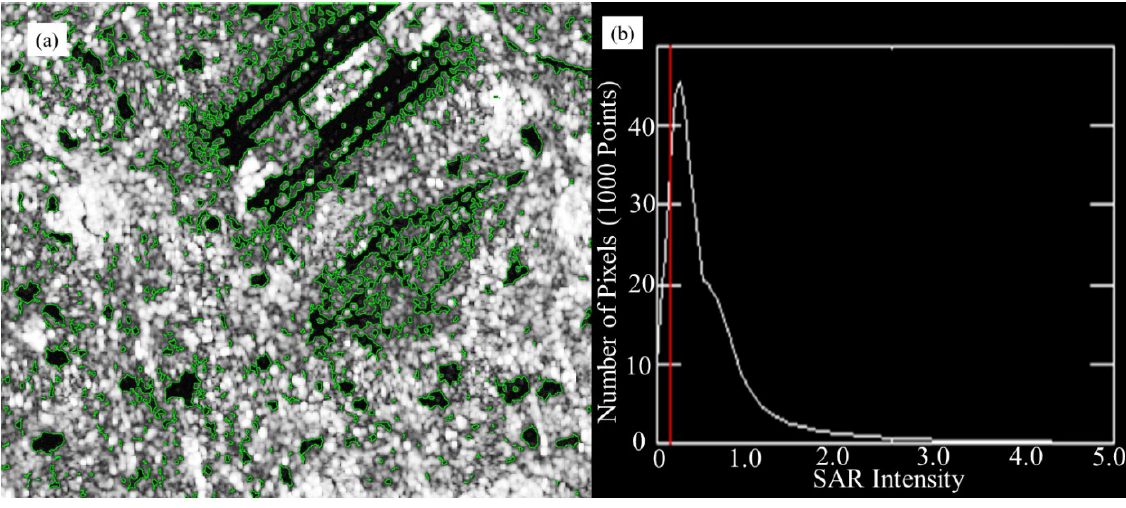
Figure 5. An example of the low ratio of the dark region in one scene. ( a ) Dark regions determined by ESARIWDS (green polygons). ( b ) Histogram of the current scene, which exhibits a pattern of a single